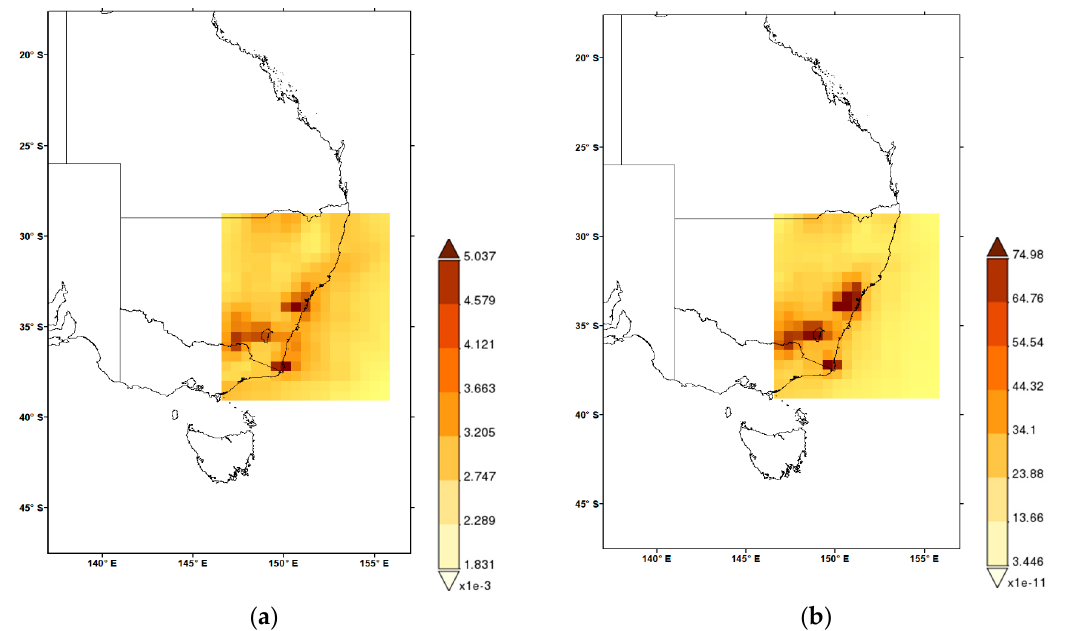
Figure 16. ( a ) Time averaged map (May 2016) of black carbon extinction AOT 550 nm monthly 0.5° × 0.625° (MERRA-2 Model M2TMNXAER v5.12.4); and ( b ) time averaged map of black carbon surface mass concentration monthly 0.5° × 0.625° (MERRA-2 Model M2TMNXAER v5.12.4) kgm − 3 . High monthly values of BC column AOT and surface concentration in the Blue Mountains and the Riverina region can be seen.